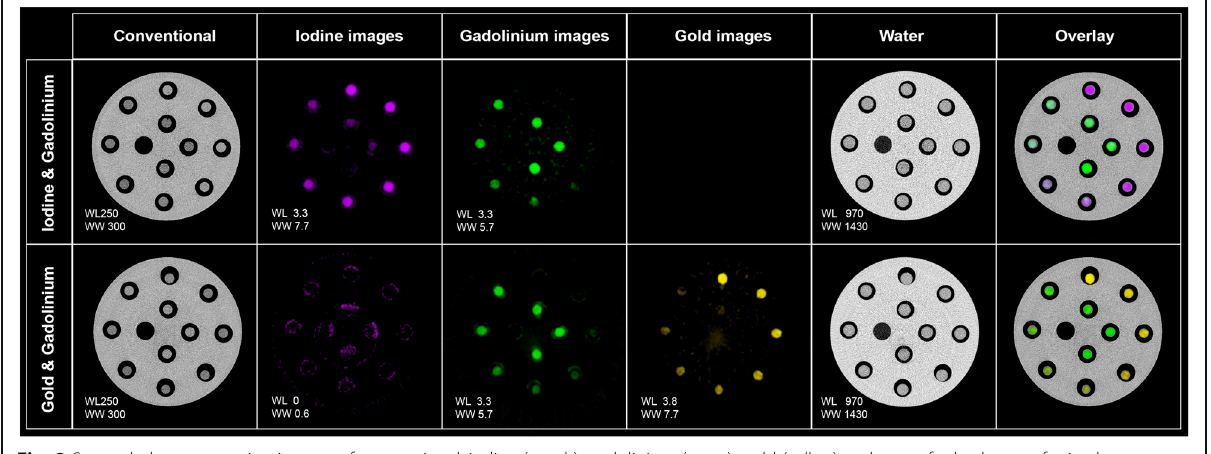
Fig. 2 Spectral photon-counting images of conventional, iodine ( purple ), gadolinium ( green ), gold ( yellow ) and water for both sets of mixed contrast agents. Top : iodine – gadolinium mixture; bottom : gold – gadolinium mixture; conventional image units are HU and material images (water, iodine, gold, gadolinium) units are mg/mL. Note that no gold image was generated from the material decomposition process for the iodine – gadolinium mixture, whereas an iodine image was generated from the material decomposition process for the gadolinium – gold mixture the gadolinium – gold mixture (gadolinium slope 0.81; gold slope 0.90), than for the iodine – gadolinium mixture (gadolinium slope 0.85; iodine slope 0.95) (Fig. 6). Add-